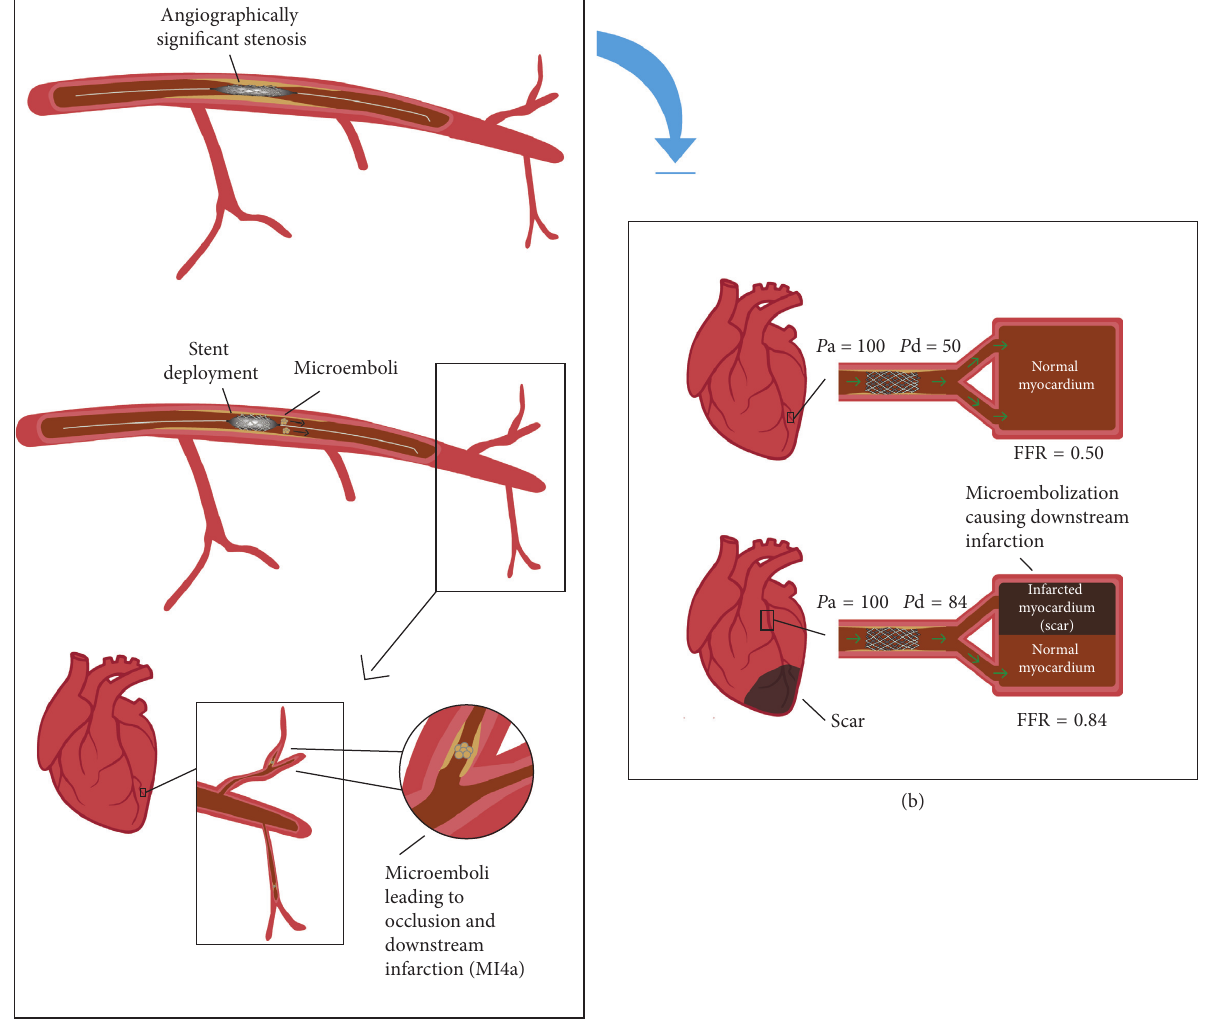
Figure 5: Illustration of falsely elevated FFR value in the setting of MI4a: (a) Depiction of downstream infarction due to MI4a. FFR calculation through a patient with a normal heart and no evidence of downstream flow limitation. (b) Falsely elevated FFR values may result secondary to MI4a. A falsely elevated FFR value in the setting of MI4A. MI4a limits the maximal achievable hyperemic flow and hence leads to a falsely elevated FFR